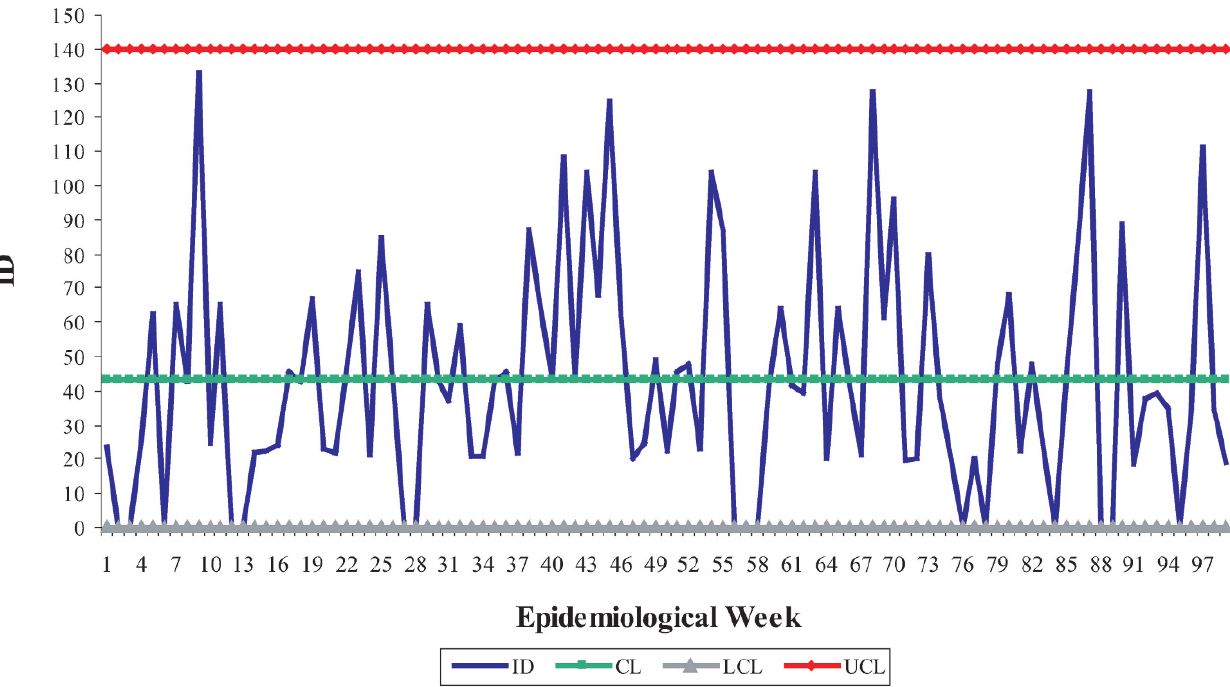
Figure 3 - The control chart of incidence densities per 1,000 patients/day in 2004 and 2005 following the steps presented in Table 3 (traditional Shewhart chart). (1) The mean value of incidence densities and the module of moving ranges were 43.13 and 36.28, respectively. (2) The limit values were CL=43.13; LCL=0, and